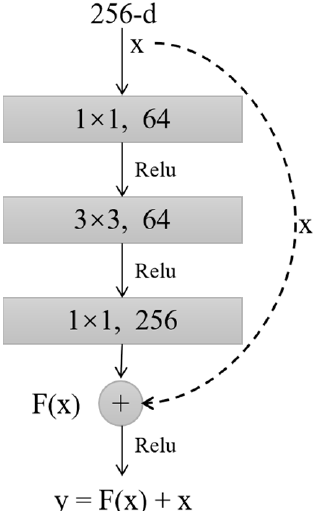
Figure 2. A “Bottleneck” building block for ResNet-50, where the 1 × 1 layers are responsible for reducing and then increasing (restoring) dimensions, leaving the 3 × 3 layer with a bottleneck of smaller input/output